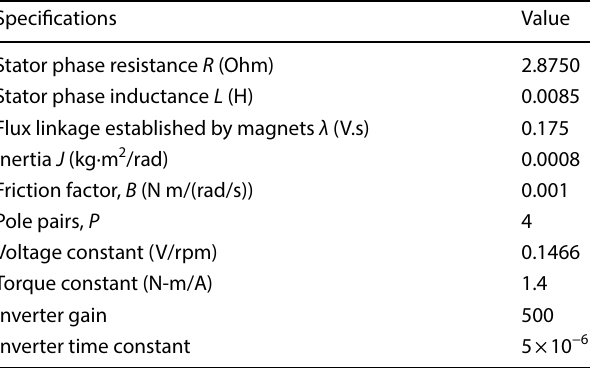
Table 3 Specifications for BLDCM